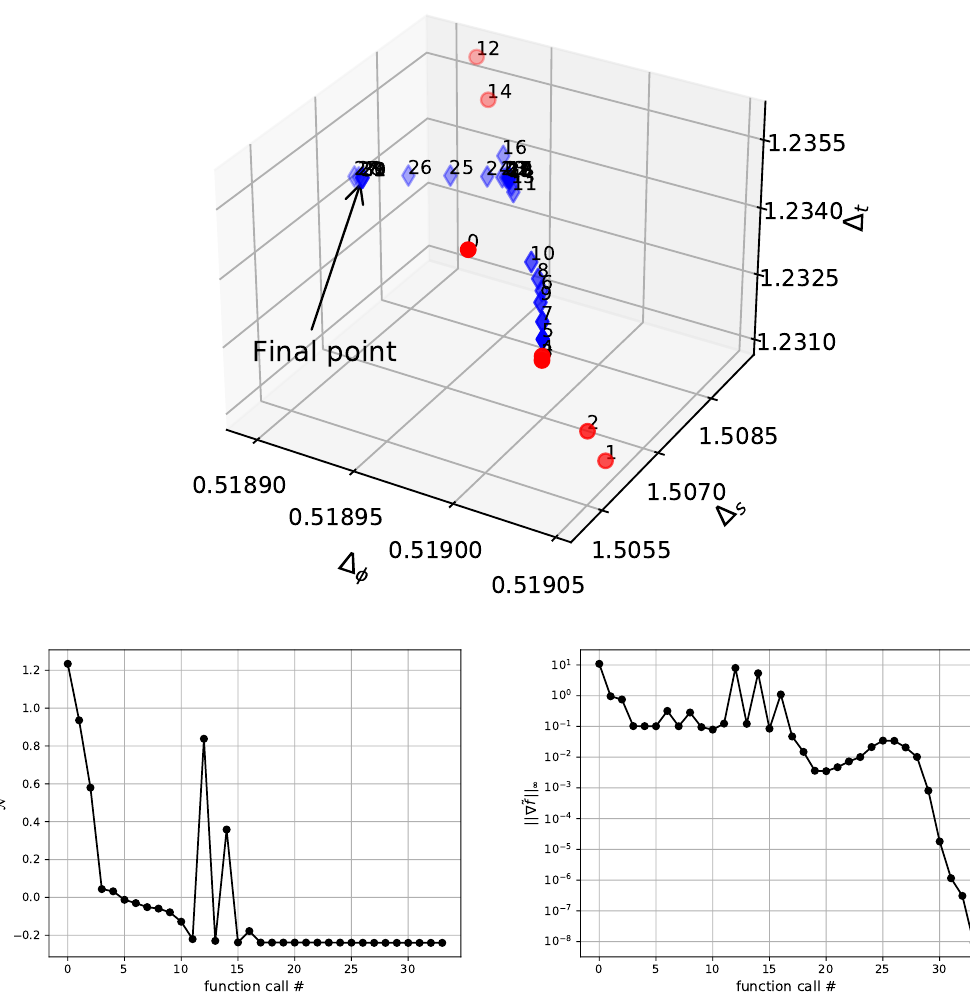
Figure 1: Top: BFGS run for the example described in Section 3 at derivative order Λ = 19. Points are numbered, starting from 0, by their function call number (and not the BFGS step number). Allowed points are marked as blue diamonds, and disal- lowed as red dots. Bottom left: Value of the navigator function at every function call. We can see it takes 5 function calls to reach the island. Bottom right: Maximum norm of the gradient, in the coordinates of eq. (24), of the transformed function eq. (5). BFGS terminates once the norm goes below gtol = 10 − 8